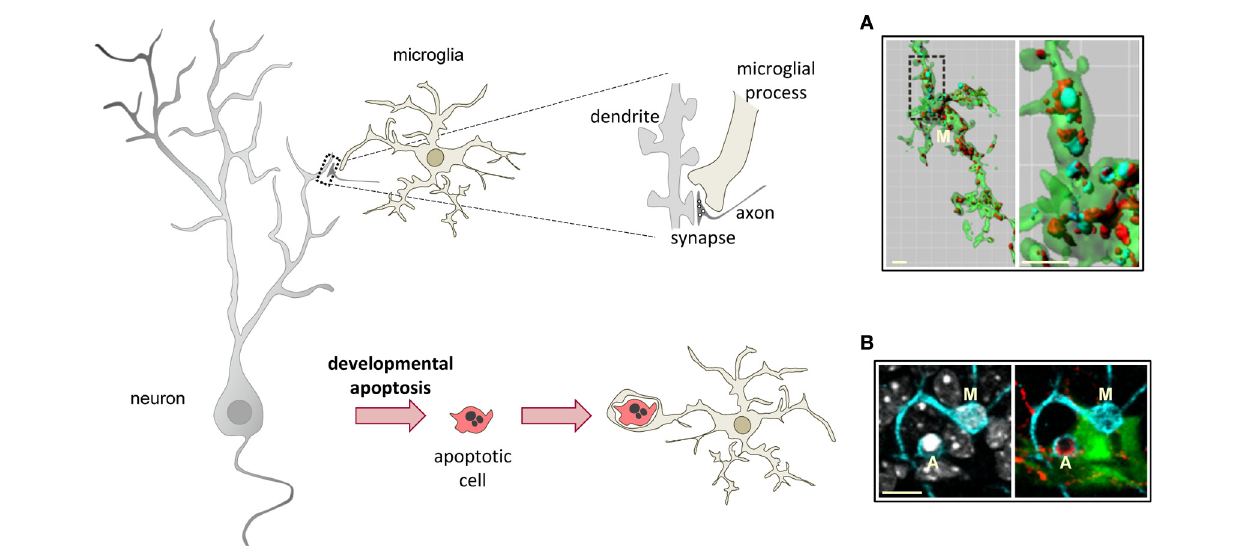
FIGURE 3 | Microglial phagocytosis in health. Motile, ramified, unchallenged microglia phagocytose neurites ( A , dendritic spines, axons) and developmentally apoptotic neurons (B) in physiological conditions in the adult and developing brain. (A) Surface-rendered CX3CR1 + /EGFP microglia (M; green) from the dorsolateral geniculate nucleus engulfing ipsi- (blue, labeled with cholera-toxin (B) conjugated to Alexa 647) and contralateral (red, labeled labeled with cholera-toxin (B) conjugated to Alexa 594) inputs from retinal ganglion cells at postnatal day 5, when robust pruning occurs. The insert is shown at higher magnification on the